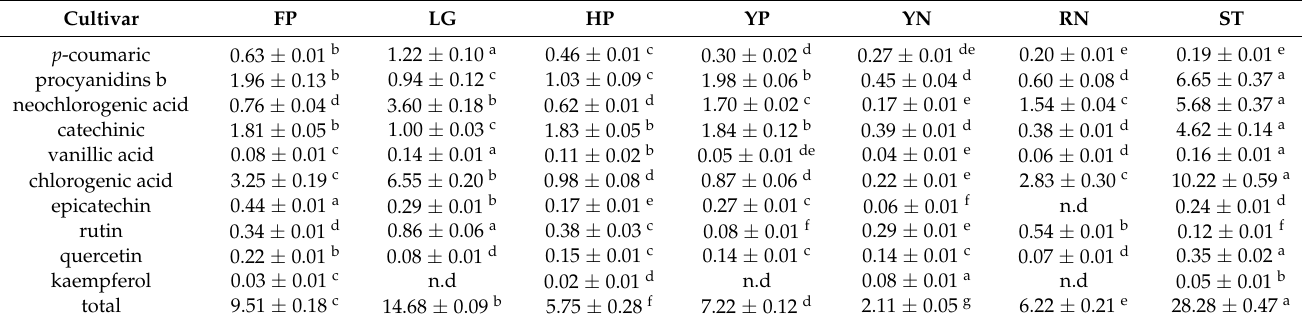
Table 5. Phenolic compounds (mg/g) of seven peach